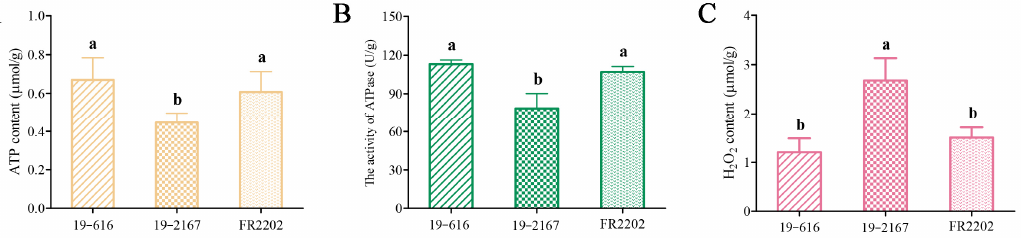
Figure 6. Mitochondrial biochemical indices among three lines. ( A ) ATP content. ( B ) ATPase activity. ( C ) H 2 O 2 content. Signi fi cant di ff erences between samples labeled with di ff erent Roman le tt ers (a, b) were determined by Turkey’s tests. p < 0.05. ( C ) H 2 O 2 content. Significant differences between samples labeled with different Roman letters (a, b) were determined by Turkey’s tests. p <